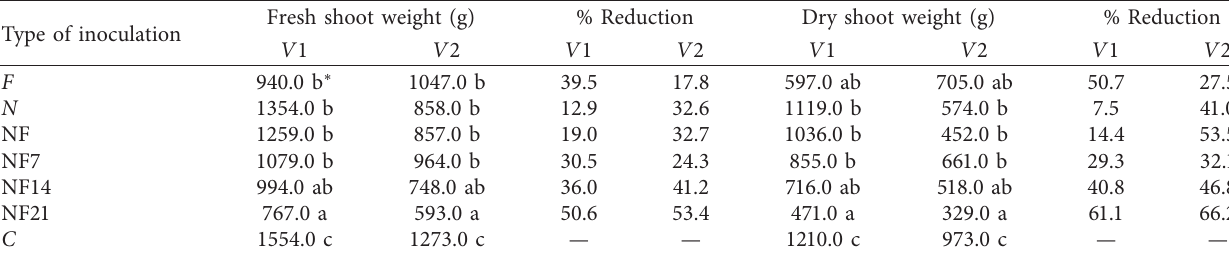
Table 1: Fresh and dry shoot weights for “Essoumtem” and “Clemson spineless” under various inoculations in pot experiment. Type of inoculation